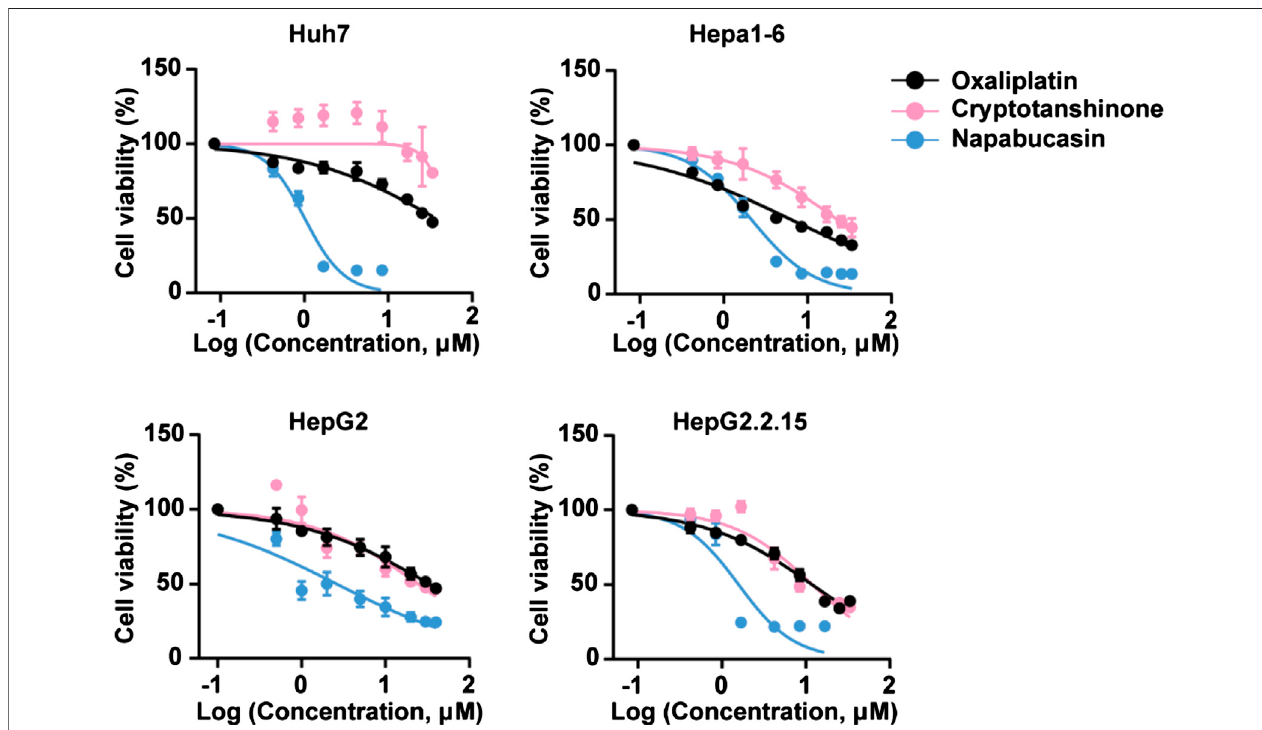
FIGURE 1 | Napabucasin decreases the viability of HCC cells in vitro . Viability of HCC cells incubated with DMSO or indicated concentrations of oxaliplatin, cryptotanshinone and napabucasin for 48 h. Data are representative of three independent experiments.